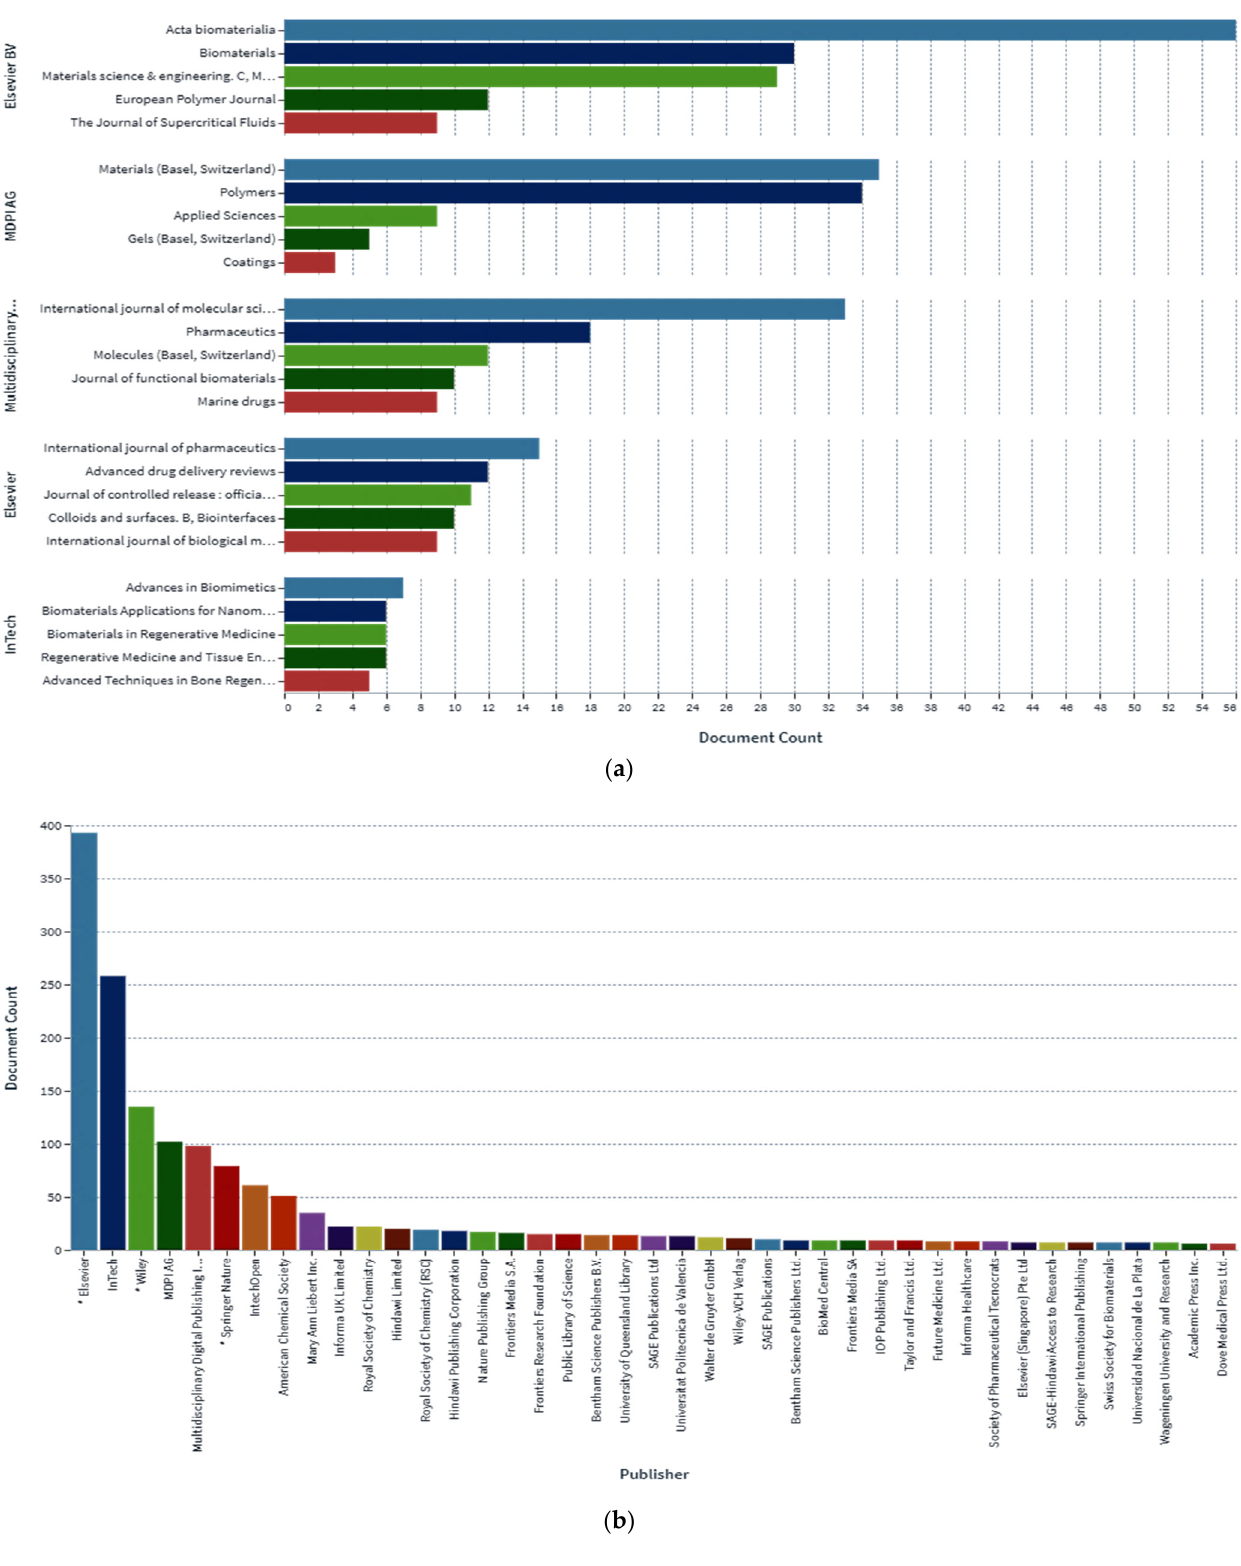
Figure 16. ( a ) Number of relevant articles ( n = 88) by journal. ( b ) Number of relevant journal articles ( n = 88) by publisher.